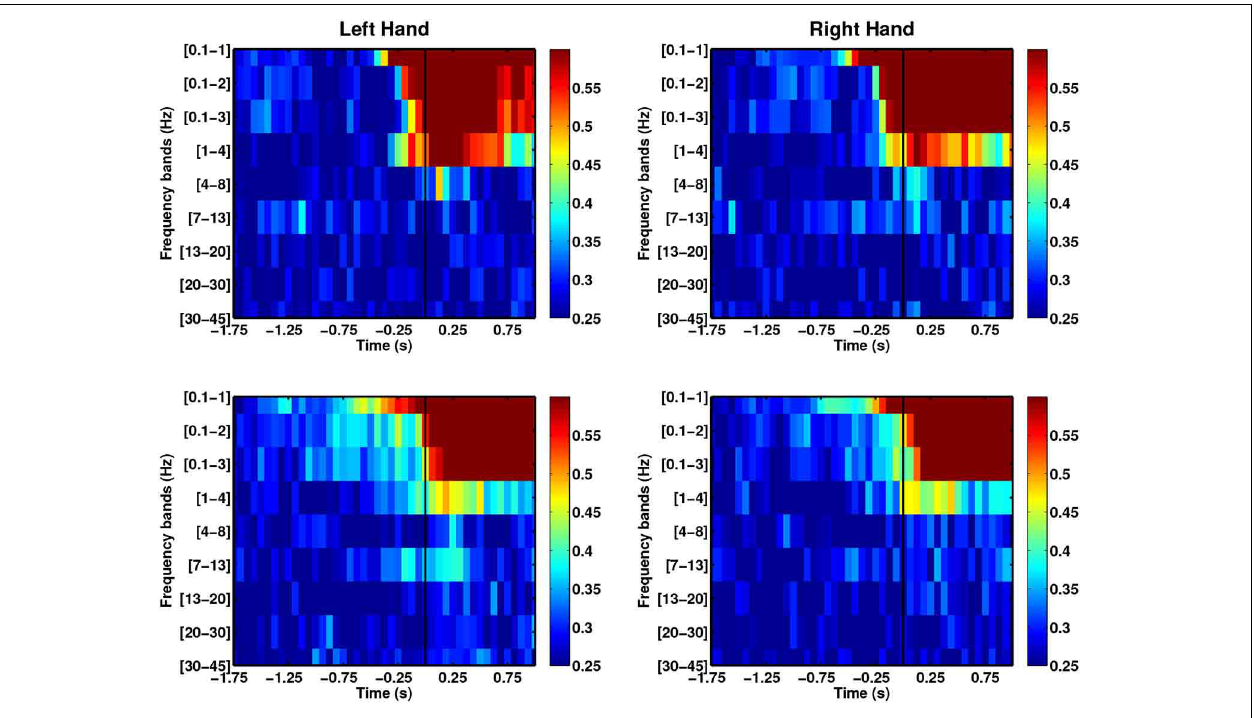
FIGURE 5 | Comparison of average DAs for different EEG frequency bands for able-bodied subjects who executed left and right hand reach movements. Both able-bodied subjects (first row: C1, second row: C2) are right-handed. t = 0 corresponds to the movement onset.